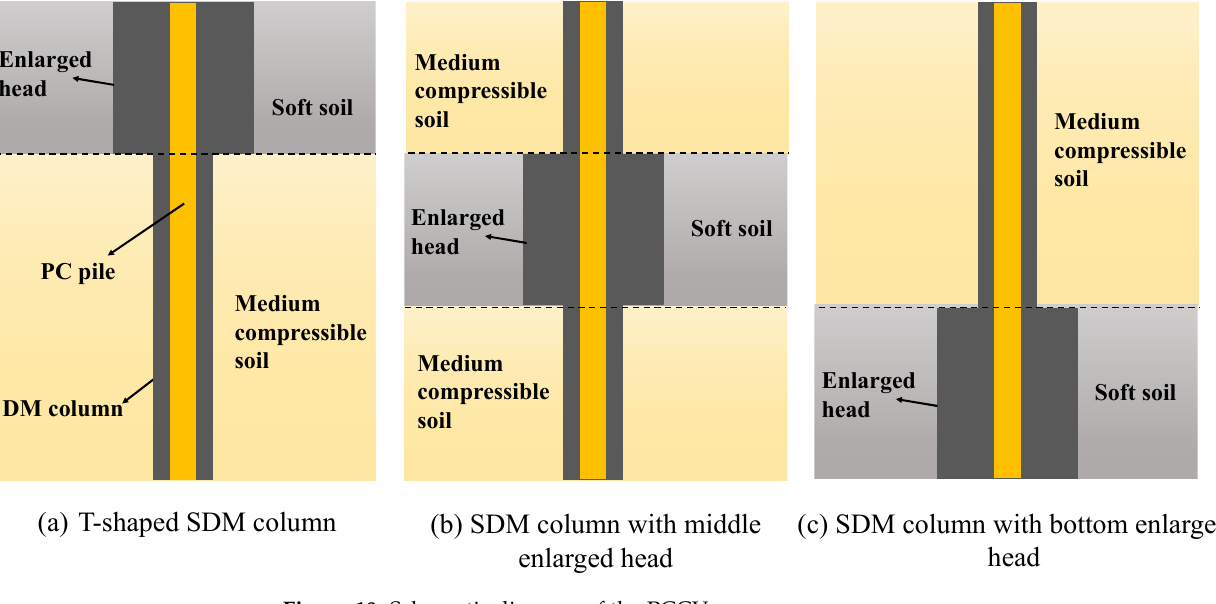
Figure 10. Schematic diagram of the PCCV.